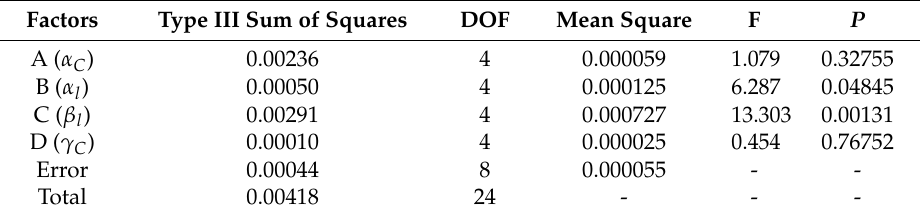
Table 8. Variance analysis results.